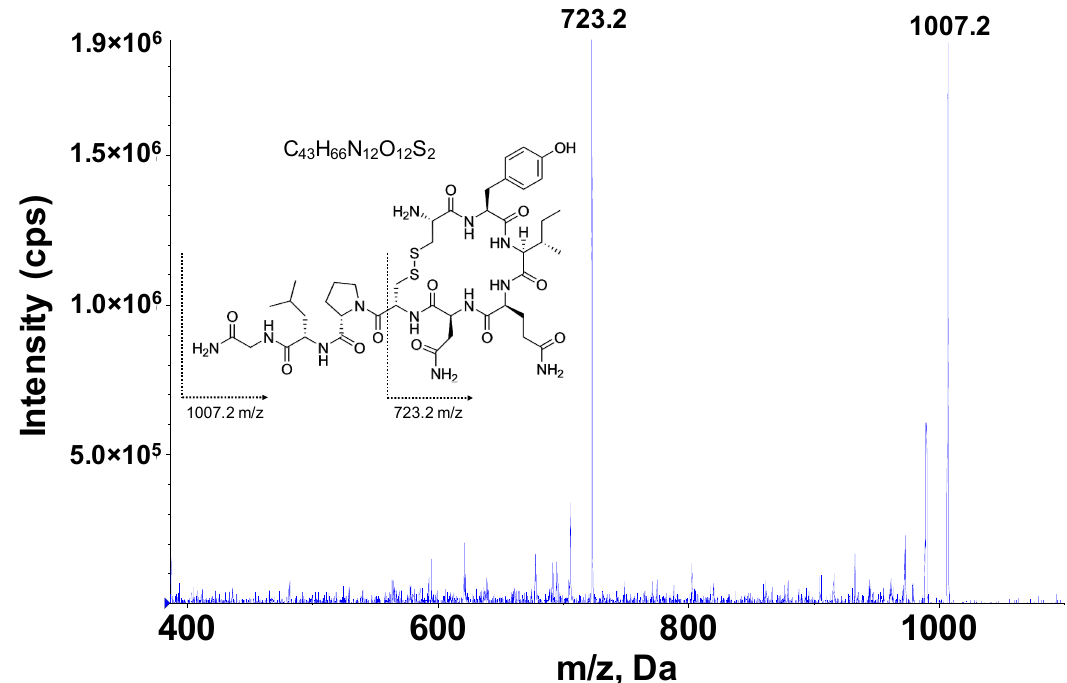
Figure 1. Mass spectra of oxytocin (OT) and its product ion. Spectra were acquired from the product ion scan. Collision energy ramped between 40–50 V.